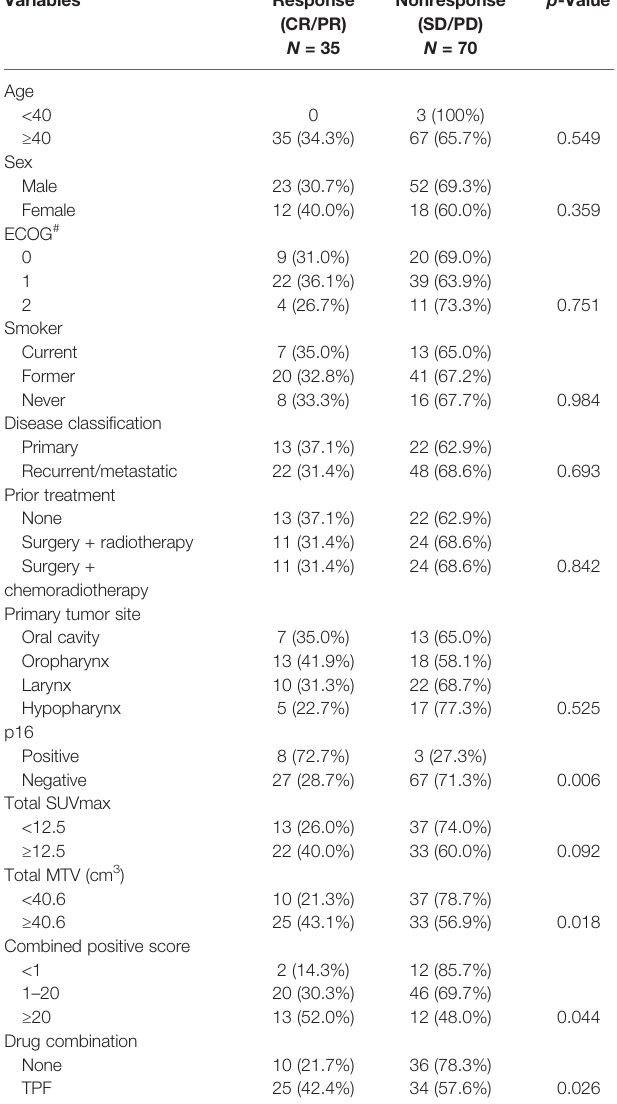
TABLE 2 | Univariate analysis of the association between general variables and treatment response in the 105 patients.